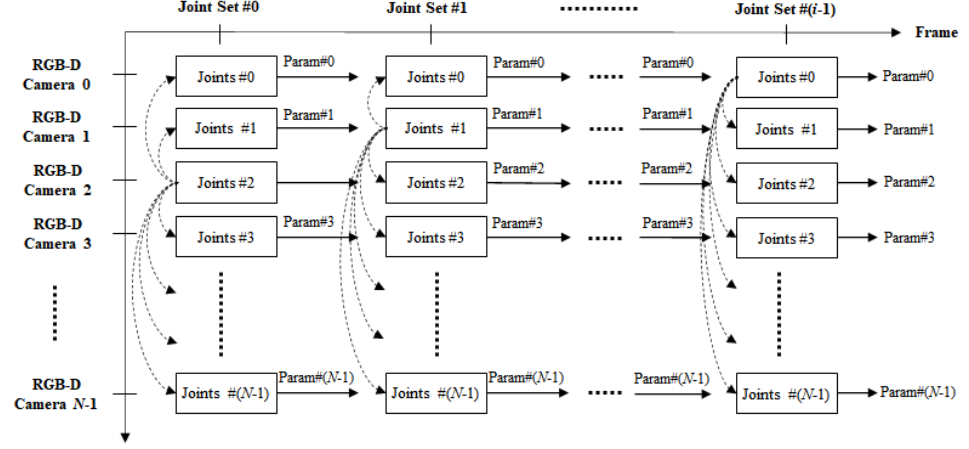
Figure 5. Temporal camera selection and parameter updating for the joint-based extrinsic